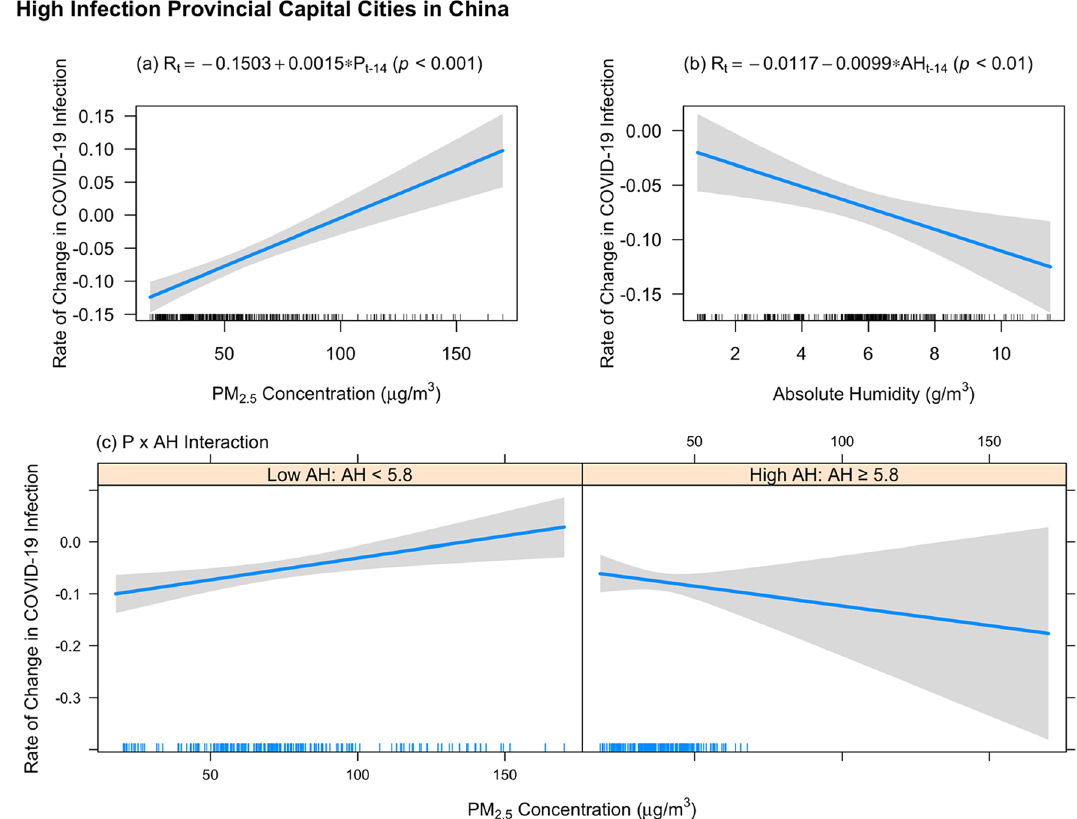
Figure 2. Significant P, AH, and P x AH determining R across 18 high infection provincial capital cities in China. (a) Univariate regression of significant P determining R, (b) univariate regression of significant AH determining R, and (c) interaction of significant P × AH determining R. The line (with confidence interval) in each plot represents the best-fit line that predicts R. The lines in the x-axis in each plot represent the observed data points.